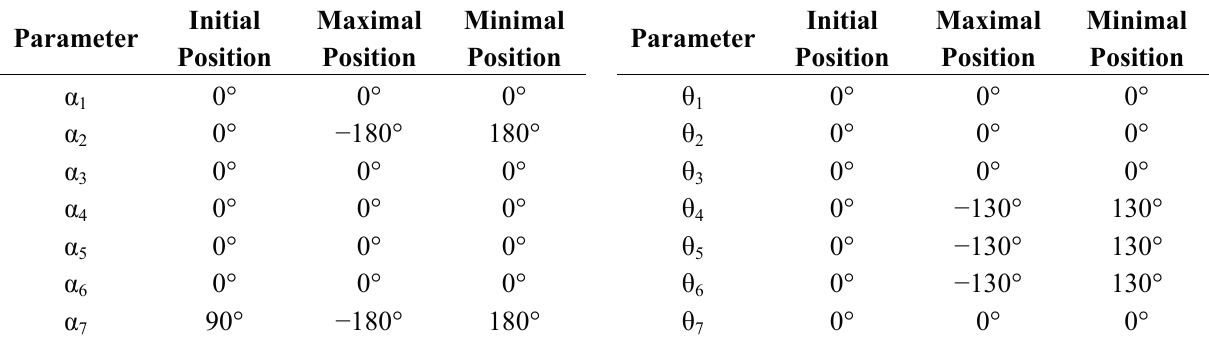
Table 3. Ranges of the parameters α and theta θ of the joints.